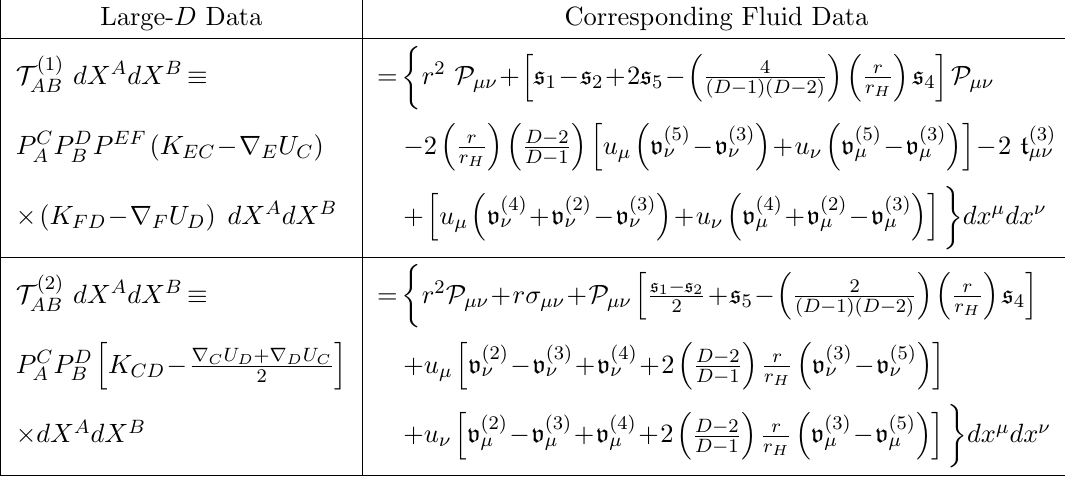
Table 4 . Tensor large- D Data in terms of (cid:13)uid